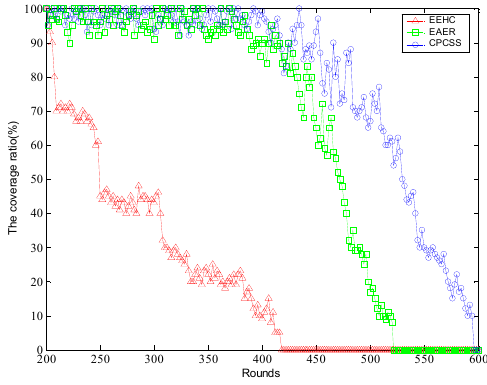
Figure 10. Comparison of the coverage ratio over rounds.